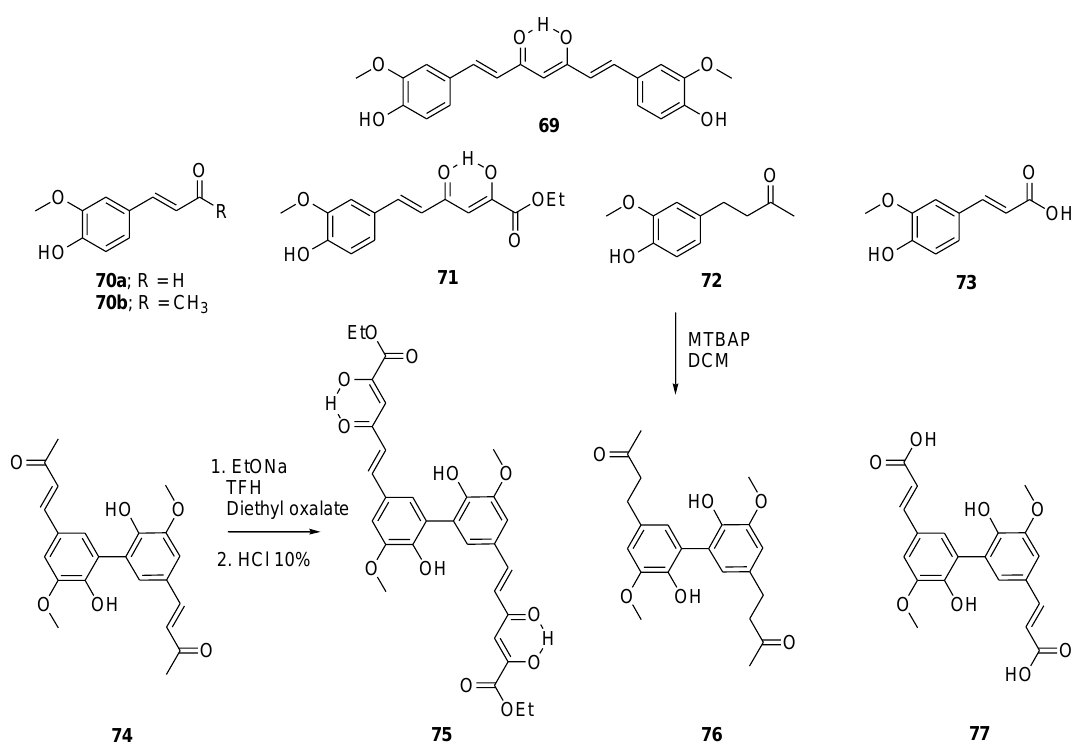
Figure 15. Representation of curcumin ( 69 ) and related compounds 70 – 77 .